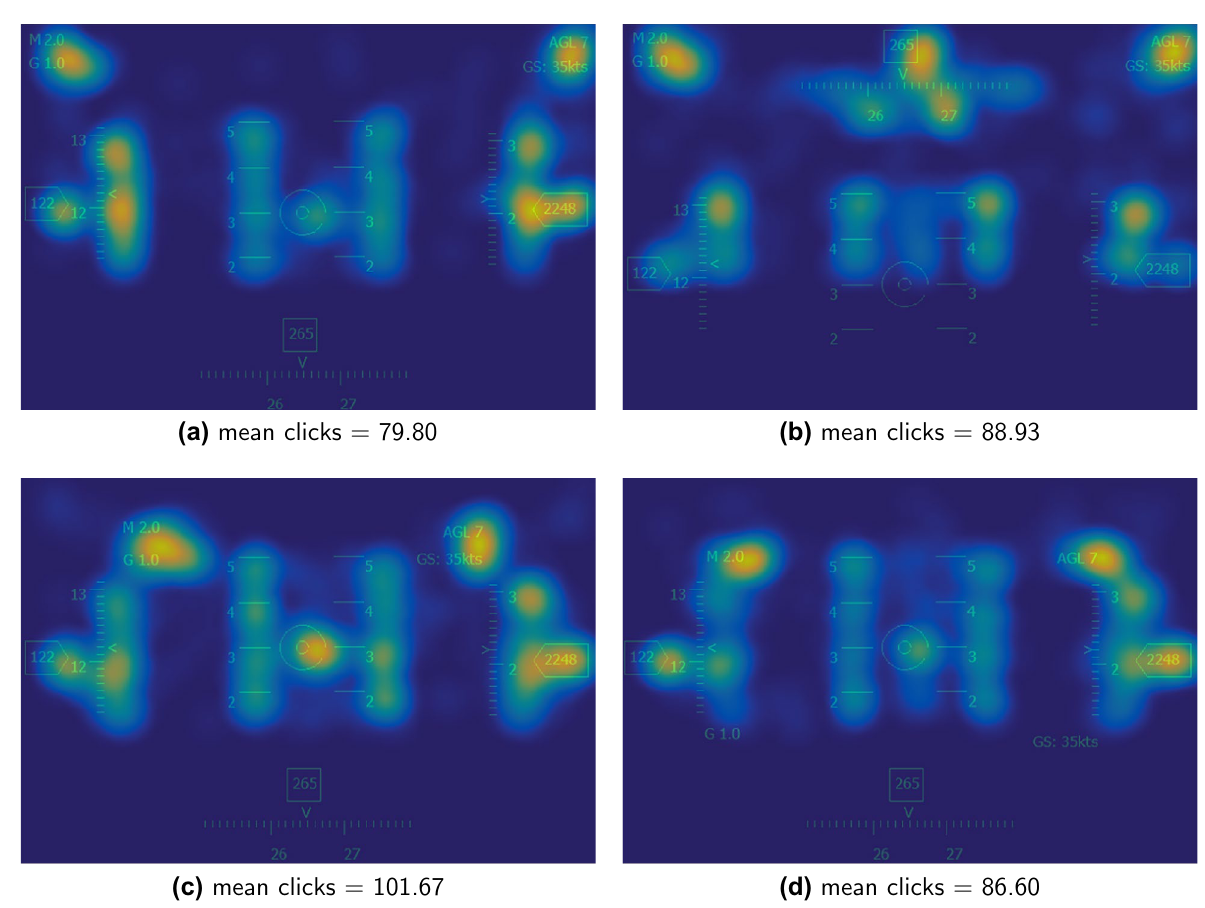
Fig. 8 Mean clicks under different HMD interfaces. The color more bright, the more attention resources the participants allocate in this